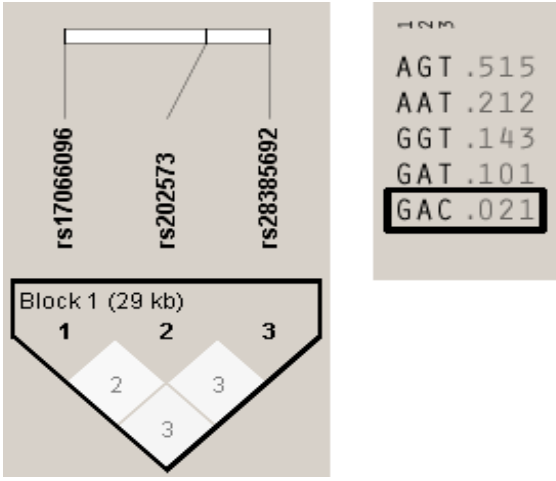
Figure A2. Haplotypes formed by the three SNPs genotyped in the Basque Country, Madrid, Andalucía, Barcelona and Germany populations. The three SNPs were considered in a single haplotype block. On the left, LD plot showing pairwise r 2 values between the SNPs. On the right, the 5 SNP haplotypes present in the combined cohorts. The only haplotype containing the C allele of rs28385692 is boxed.